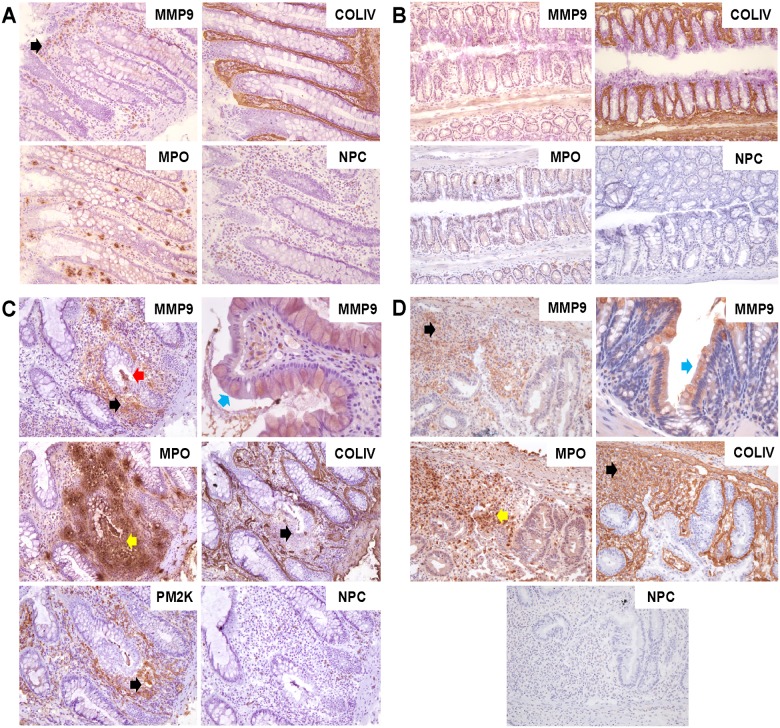
MMP9 expression and association with disease in ulcerative colitis and in DSS-induced colitis.IHC was conducted on serial sections of frozen human non-diseased colon tissue (from healthy individuals, or in non-diseased colonic crypts found adjacent to diseased regions in UC patient samples, n = 12 samples; representative images shown) (A) or of mouse non-diseased colon tissue (n = 2) (B). MMP9 immunoreactivity was limited, and consisted primarily of cytoplasmic staining of a subset of immune cells such as macrophages/histiocytes, lymphocytes, and neutrophils within the lamina propria and submucosal regions of the colon (black arrow). (C) IHC was conducted on serial sections of frozen human UC patient colon tissue (n = 7 patients; representative images shown) and demonstrated MMP9 induction at a disease focus (top left image, black arrow) surrounding an abscessed epithelial crypt (red arrow), and MMP9 expression coincident with regions of neutrophil (MPO, middle left image, yellow arrow) and macrophage (PM2K, bottom left image, black arrow) infiltration/expansion, as well as with regions of disrupted epithelial basement membrane (COLIV, bottom right image, black arrow). MMP9 induction in colonic epithelium was also observed (top right image, blue arrow, 400x). (D) IHC conducted on serial sections of frozen mouse DSS colitis tissue (n = 9) showed an MMP9 expression pattern similar to human UC, with MMP9 induction in a region of inflammation surrounding diseased epithelial crypts (top left image, black arrow), MMP9 induction in colonic epithelium (top right image, blue arrow, 400x), neutrophil infiltration at the active disease site (MPO, bottom left image, yellow arrow) and disruption of the epithelial basement membrane in a disease area (COLIV, bottom right image, black arrow). All images are at 200X magnification unless otherwise noted. NPC = no primary antibody control.